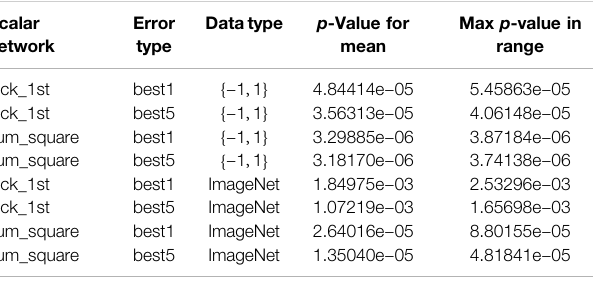
TABLE 3 | p -Values for the linear relationship between ESD and accuracy over several different scenarios including examples using both synthetic data and real ImageNet data.